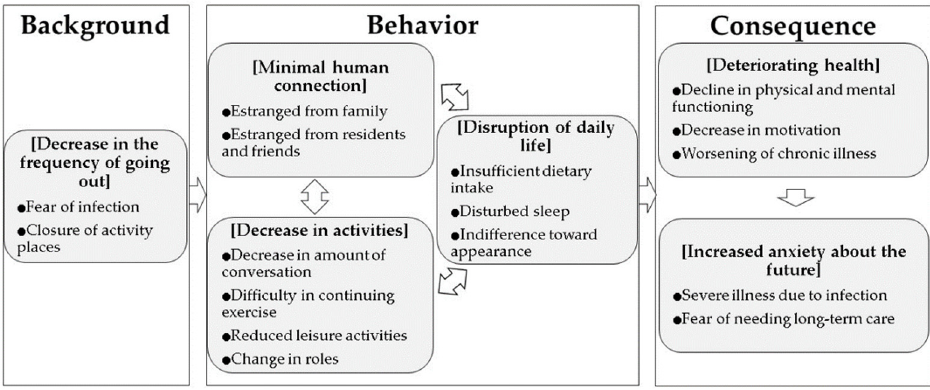
Figure 1. Lifestyle changes experienced by older adults owing to COVID-19.